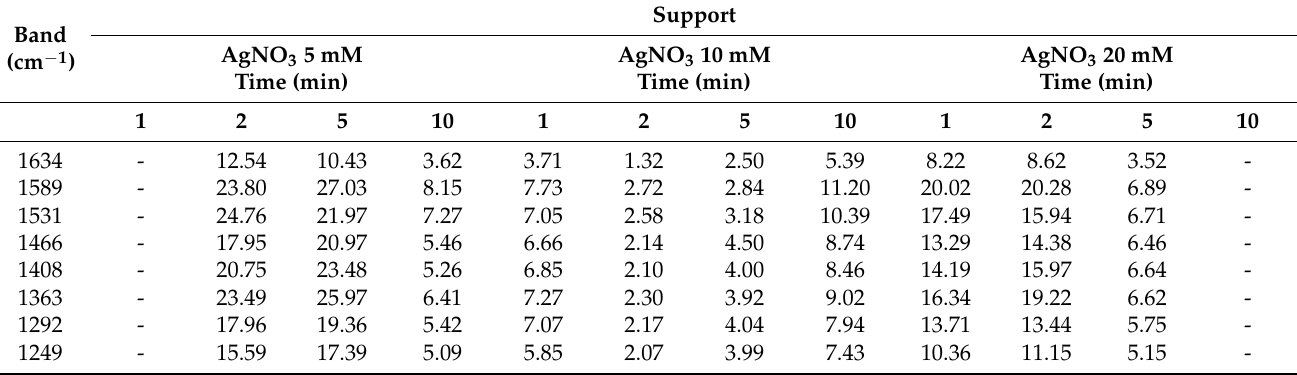
Table 5. Amplification factor obtained from the intense bands observed in the pyridine Raman spectrum.